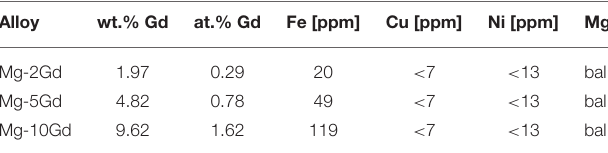
TABLE 1 | Gd concentrations were measured by X-ray fluorescence